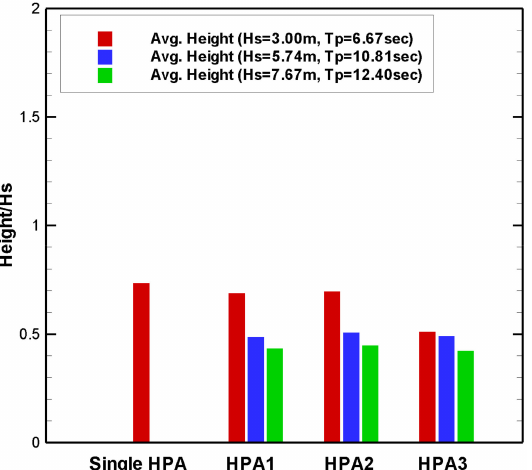
Figure 21. Motion responses of HPAs in various environmental conditions (Vc = 0.14 m/s except the single HPA, wave heading angle = 0 ◦